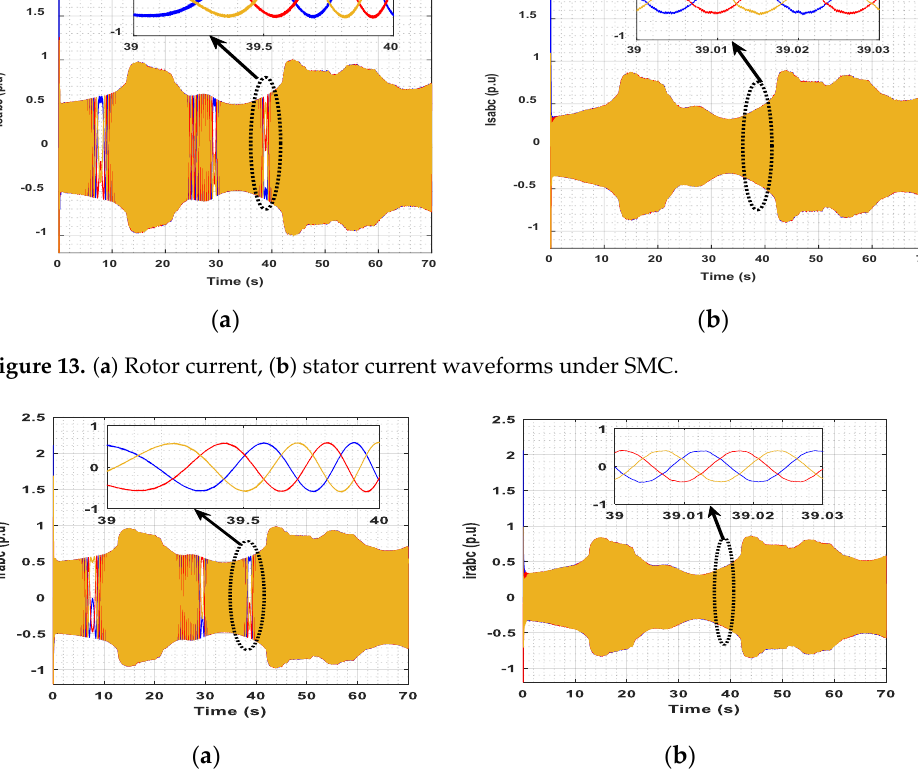
Figure 14. ( a ) Rotor current, ( b ) stator current waveforms under ABC.